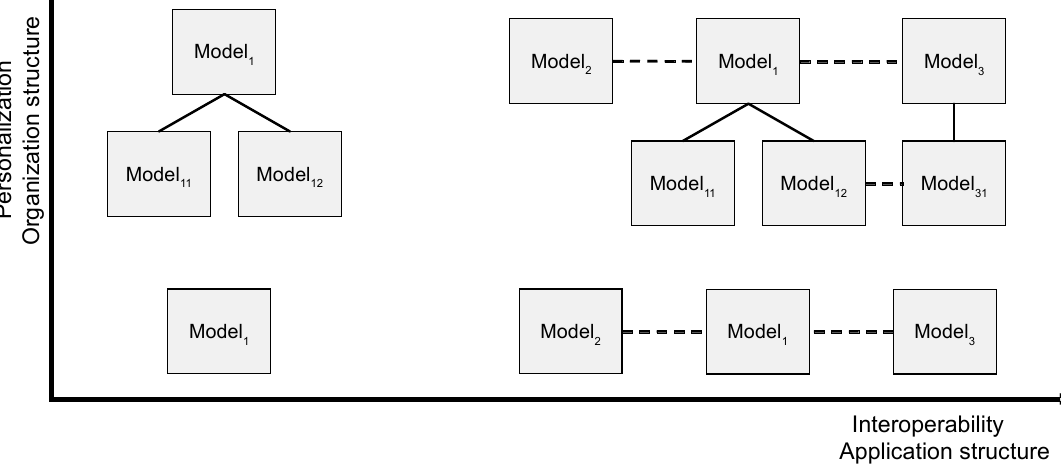
Figure 7. Dimensions of model relationships in CCM. Four model constellations that exploit model reuse and model personalization.